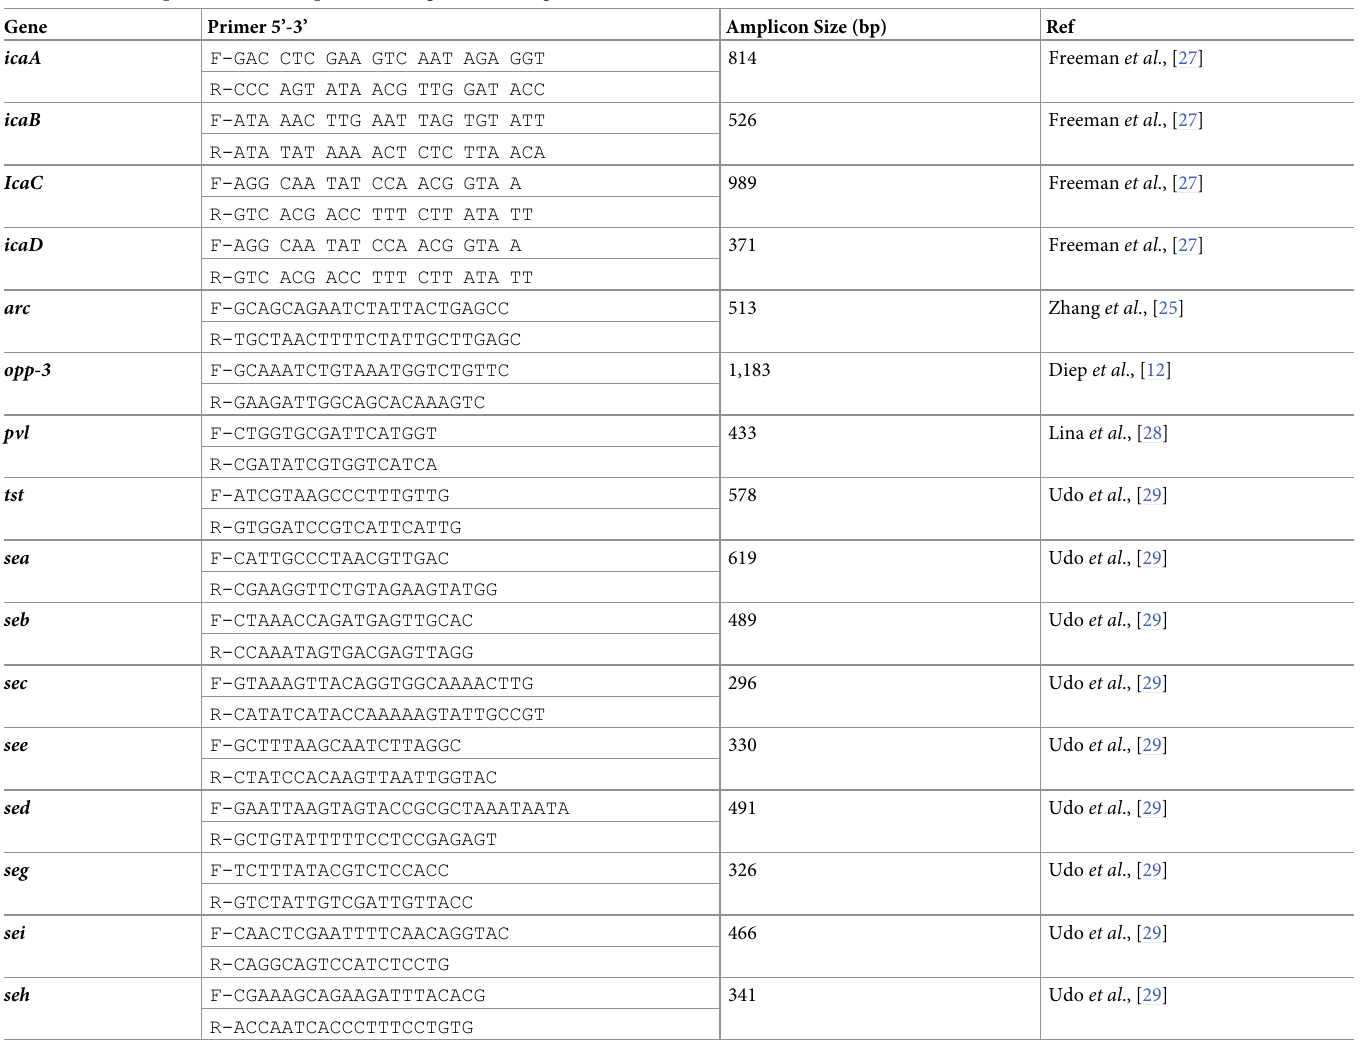
Table 1. Primer sequences for the amplification of genes encoding virulence